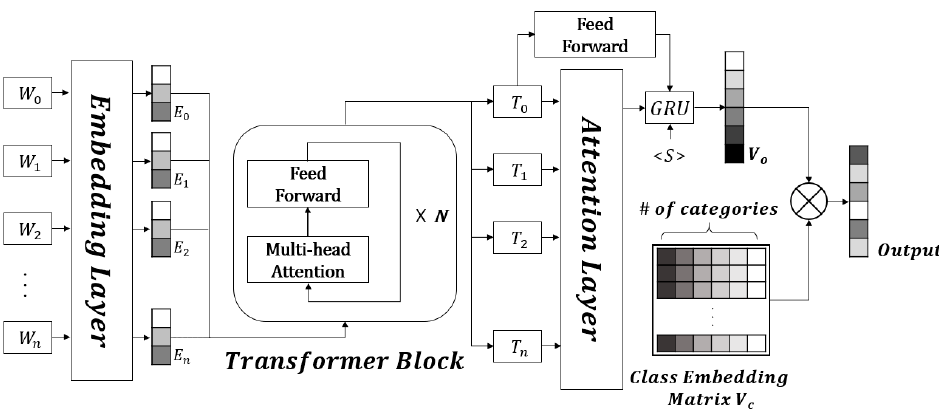
Figure 2. Overall architecture of the proposed model.